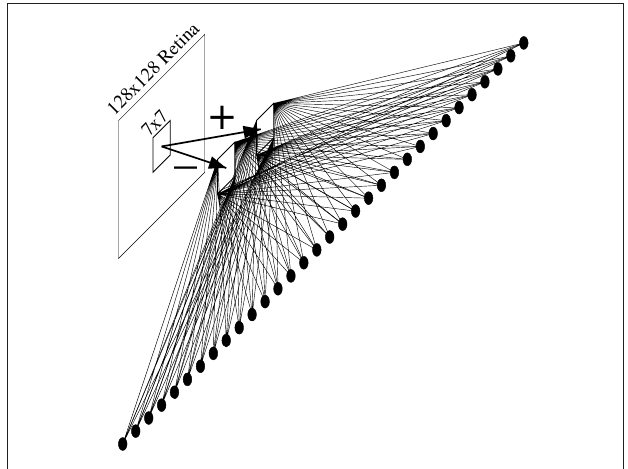
Figure 23 | Topology used for testing STDP on V1-like Network.